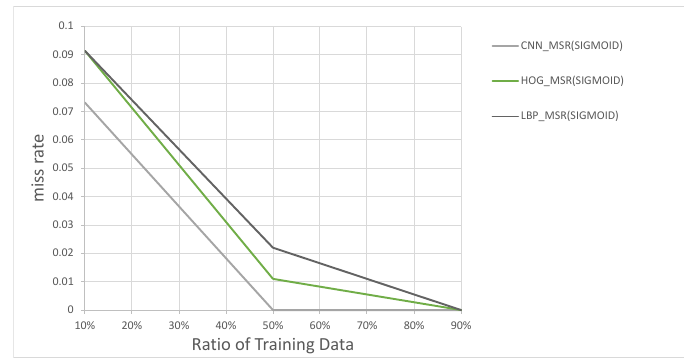
Figure 15. Classification miss rates for CNN, HOG and LBP.